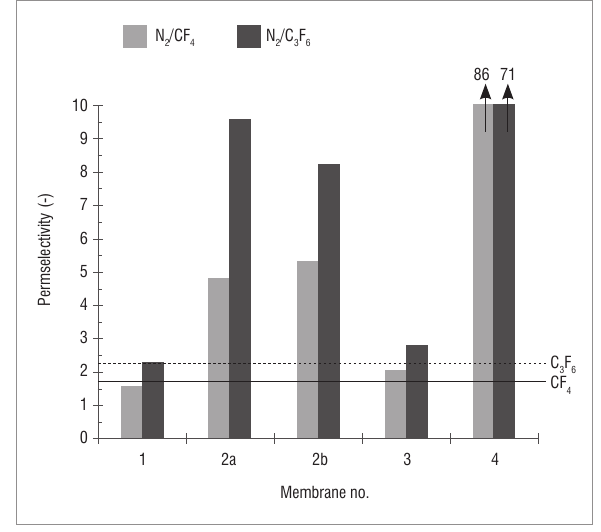
/CF and N /C F for the (1) ceramic 2 4 2 3 6